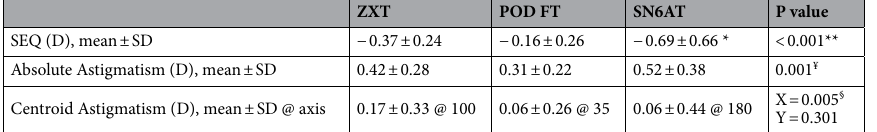
ZXT POD FT SN6AT P value SEQ (D), mean ± SD − 0.37 ± 0.24 − 0.16 ± 0.26 Absolute Astigmatism (D), mean ± SD 0.42 ±